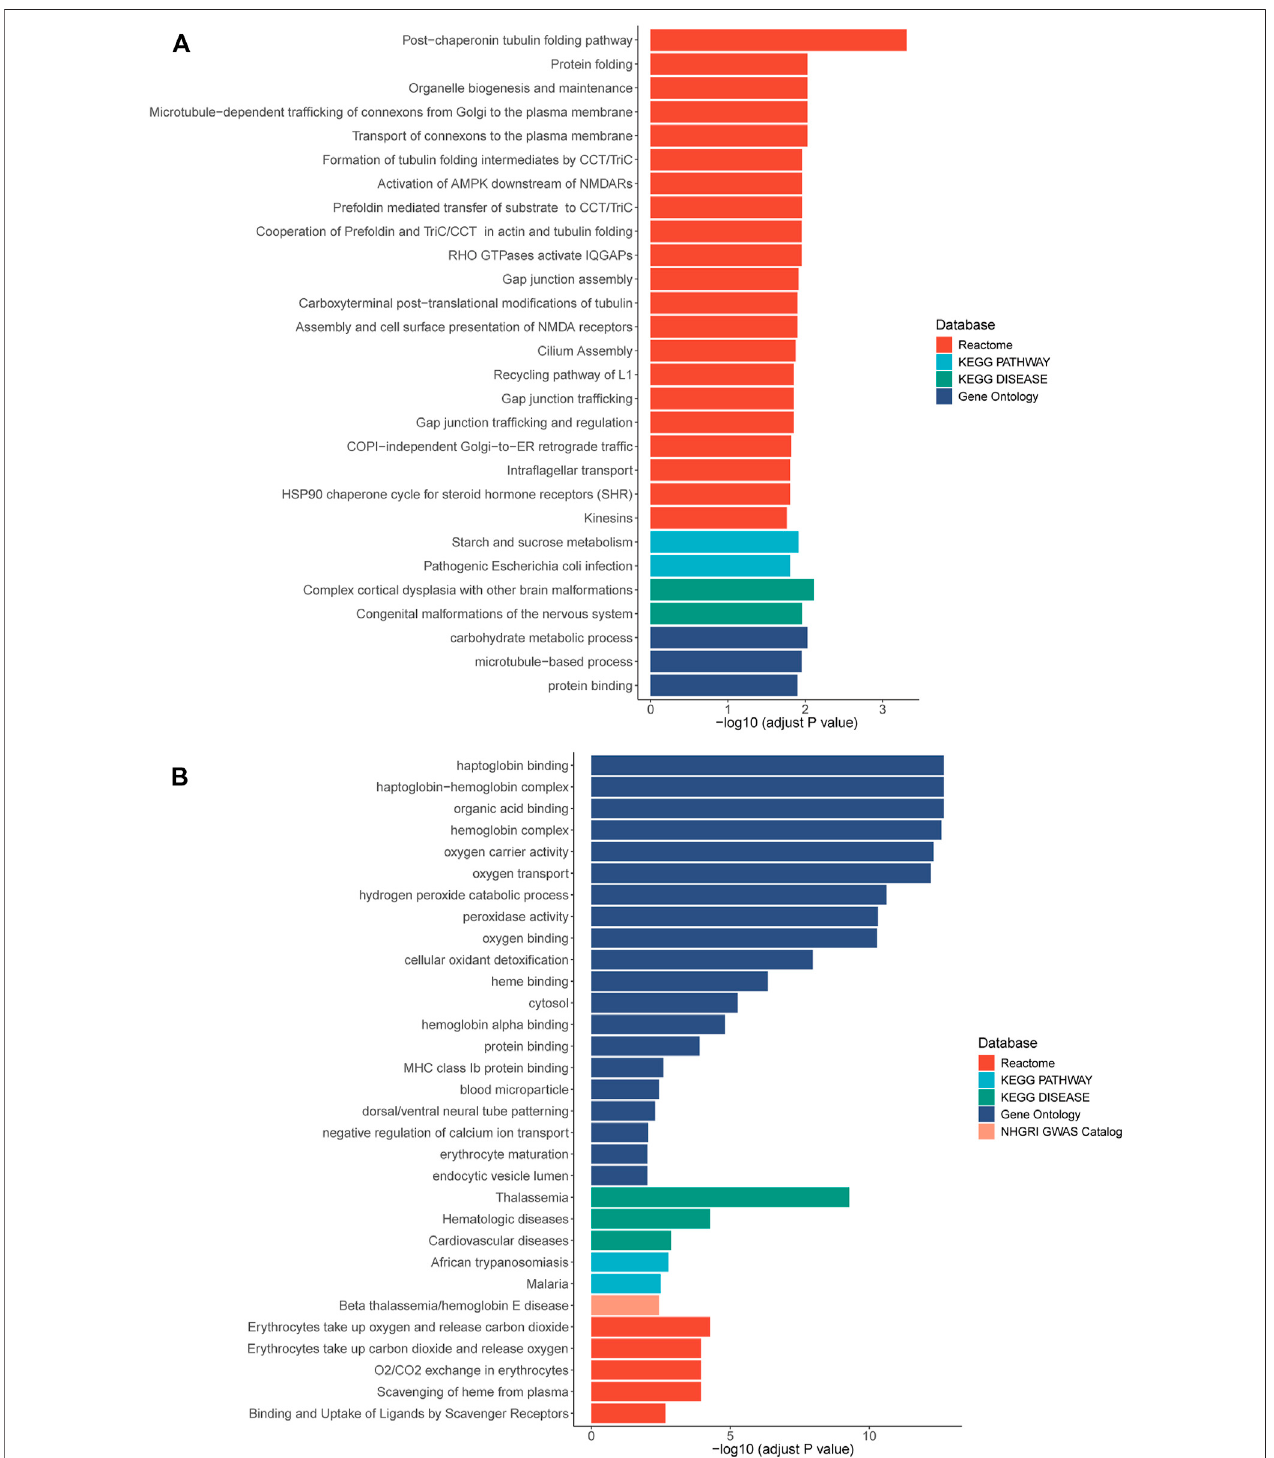
FIGURE 2 | Pathway enrichment results of genes with aberrant expression (A) and with aberrant splicing (B) . Colors stand for pathways items from different database. The X axis shows adjusted p -value with log transformed. Pathways with an adjusted p -value < 0.05 was selected as signi fi cant pathways and plotted.